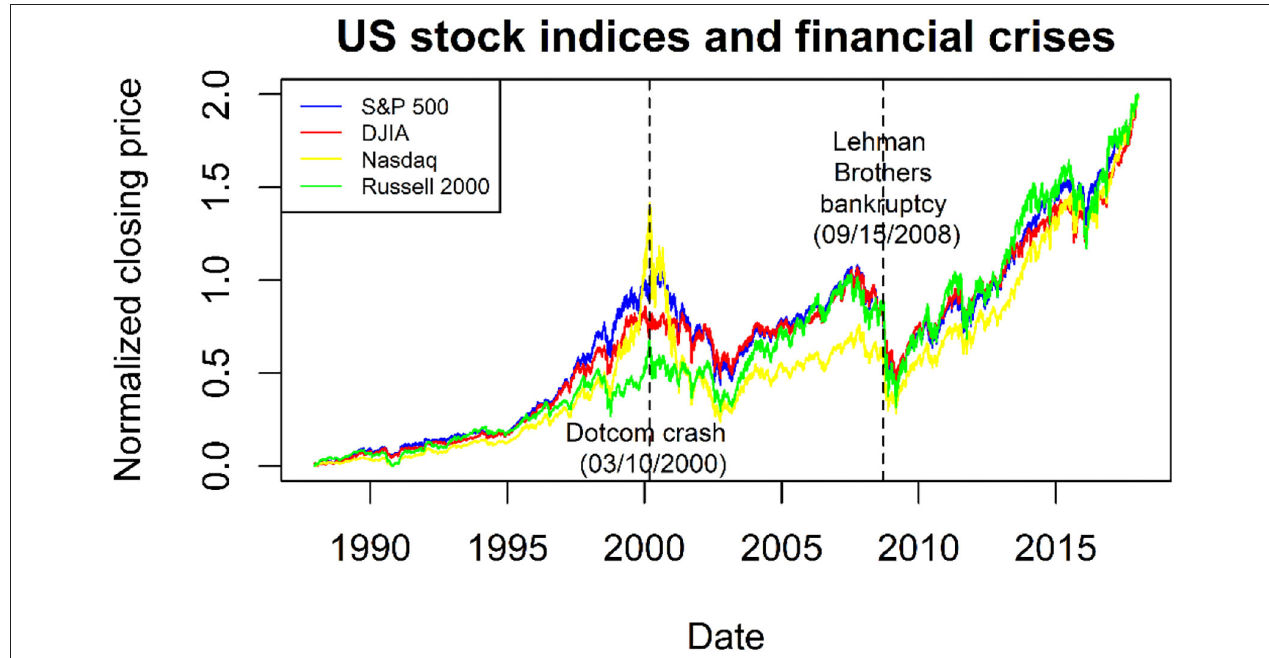
FIGURE 4 | Indices for the Standard and Poor’s 500 (S&P 500), the Dow Jones Industrial Average (DJIA), the Nasdaq Composite (Nasdaq), and the Russell 2000 Index (Russell 2000), respectively. The crisis dates for the Dotcom crash and Lehman Brothers bankruptcy also are